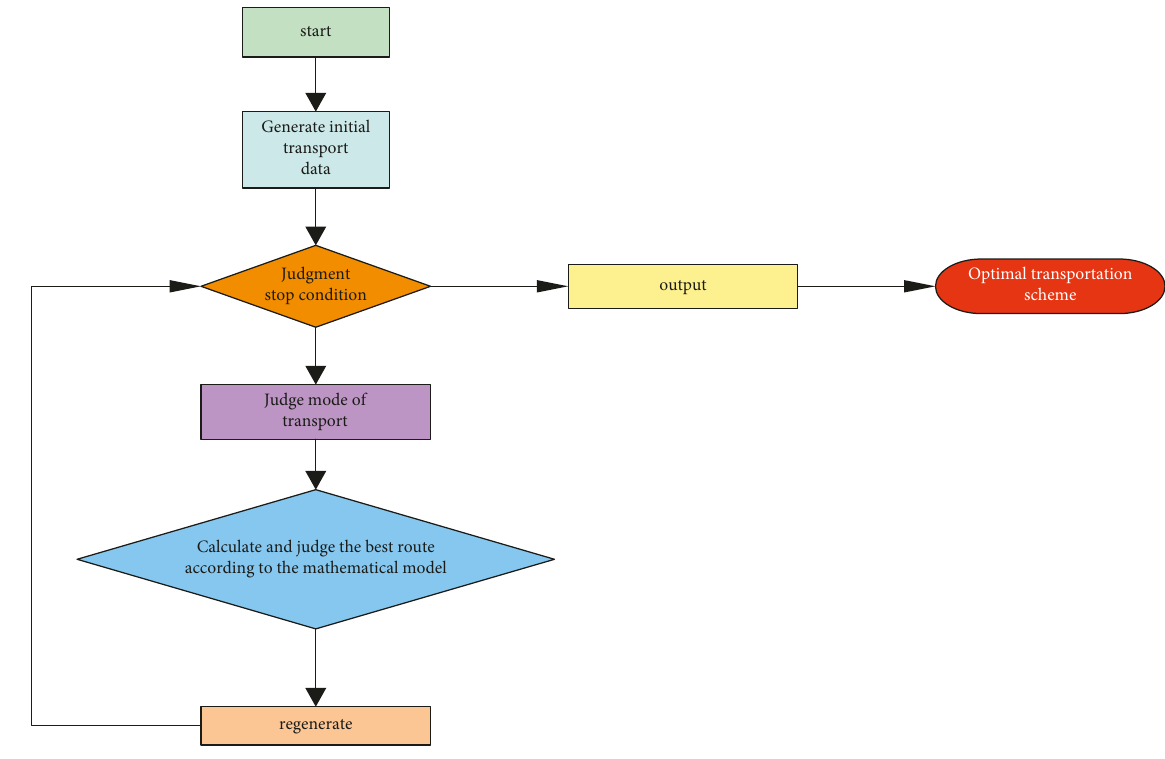
Figure 6: Genetic algorithm